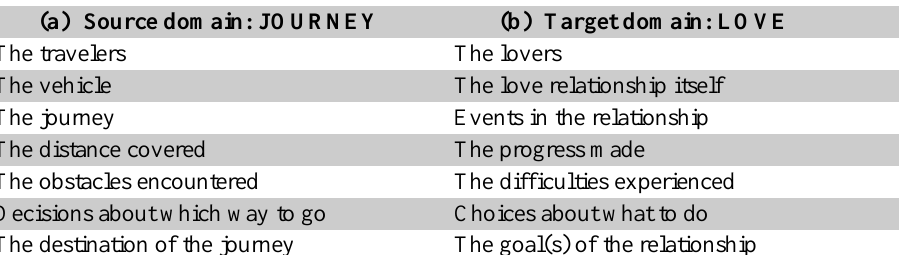
Table 1. Correspondences or Mapping of LOVE IS